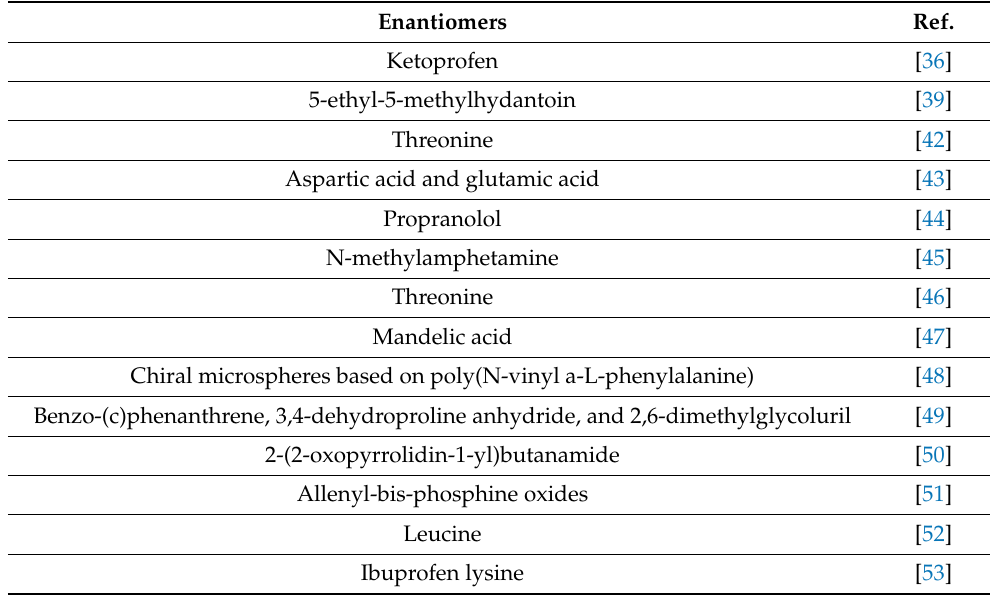
Table 5. Experimental studies of enantioresolutions applying